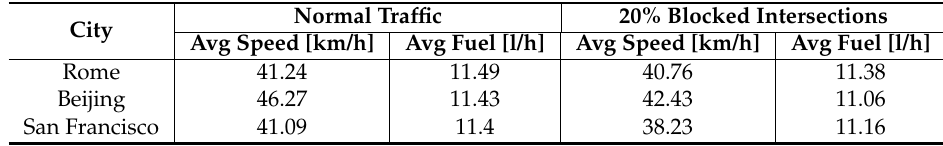
Figure 12. Blockchain storage size based on the number of blocks. Table 5. Experimental results: average speed and fuel